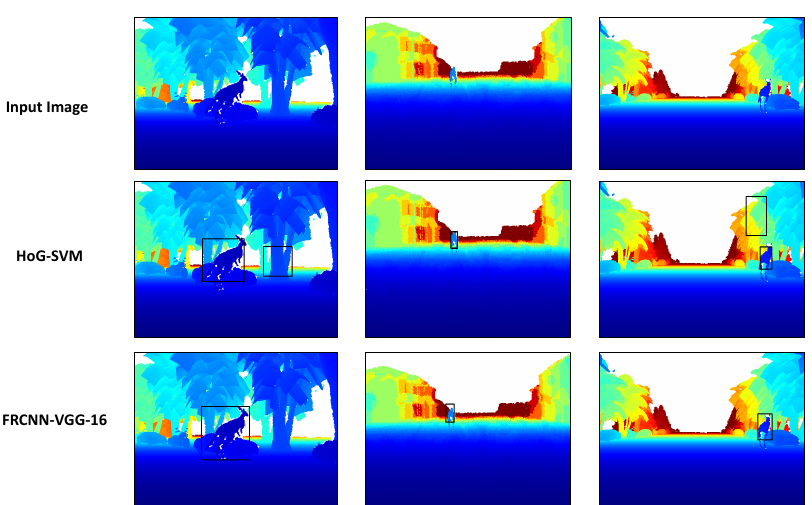
Figure 5. Evaluation on the synthetic test split data. Top : the input colorized synthetically generated depth images. Middle : output of the baseline HoG-SVM models. Bottom : prediction of proposed FRCNN-VGG-16 kangaroo detection